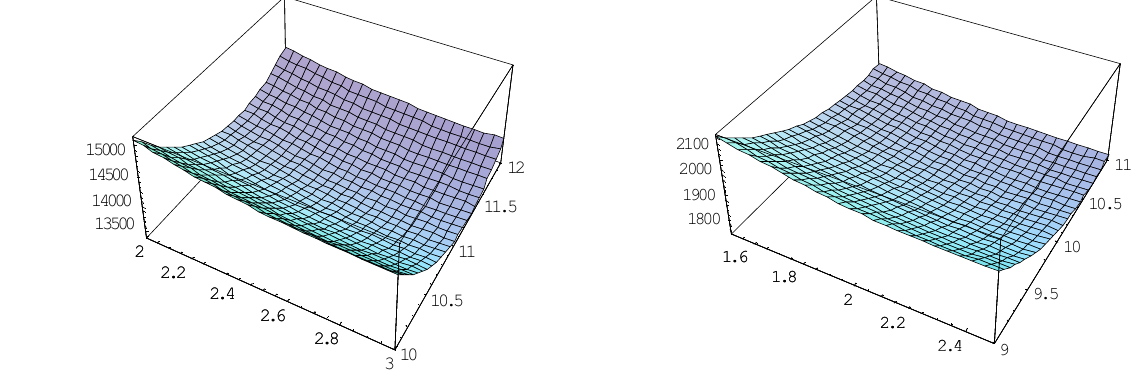
* and T* w.r.t. TC 2